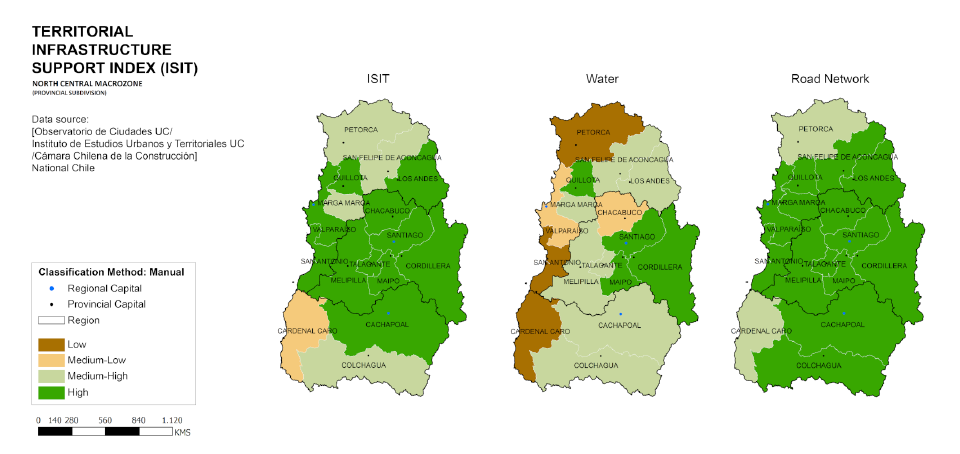
Figure 3: ISIT of provinces of the central-north macrozone